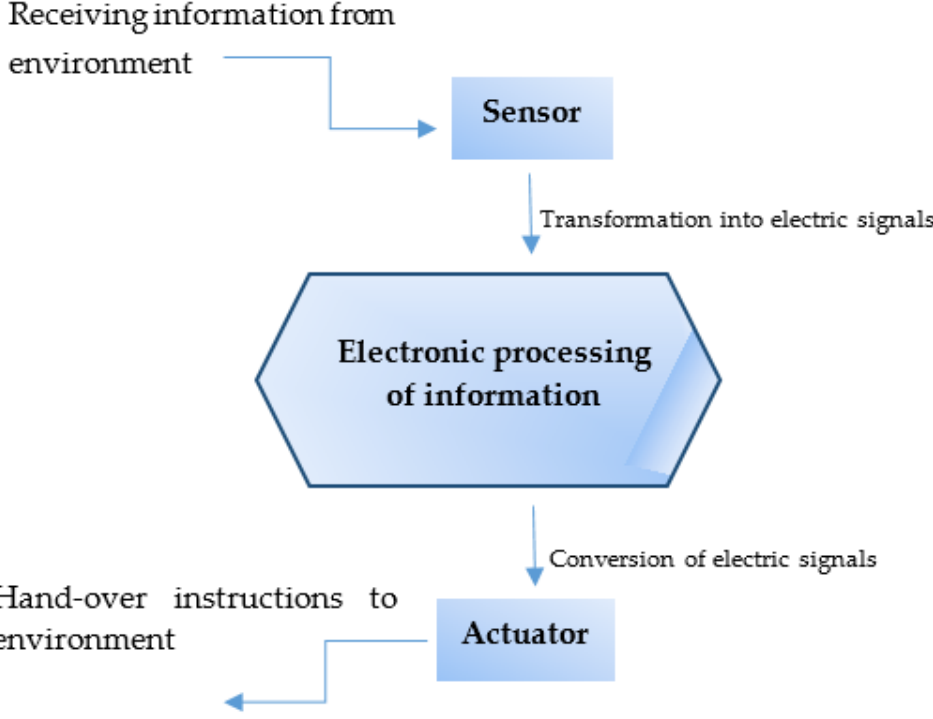
Figure 2. Principal functions of passive smart textiles.